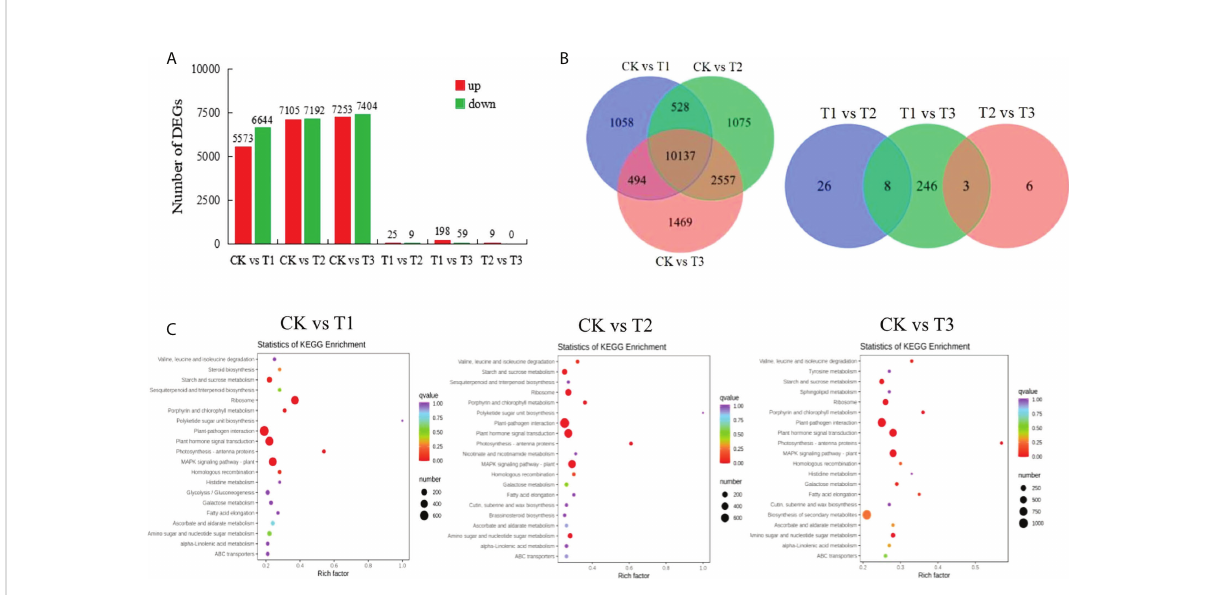
FIGURE 1 The number distribution, venn diagram and KEGG pathway enrichment map of DEGs in different sample group. (A) , The number distribution of DEGs among CK vs T1, CK vs T2, CK vs T3, T1 vs T2, T1 vs T3, T2 vs T3; (B) , Venn diagram of DEGs among CK vs T1, CK vs T2, CK vs T3, T1 vs T2, T1 vs T3, T2 vs T3; (C) , KEGG pathway enrichment map of DEGs among CK vs T1, CK vs T2, CK vs T3. CK refers to the control, T1 refers to 200 µ mol L − 1 Cd treatment, T2 refers to the treatment of 50 µ mol L − 1 MT+200 µ mol L − 1 Cd, T3 refers to the treatment of 100 µ mol L − 1 MT +200 µ mol L − 1